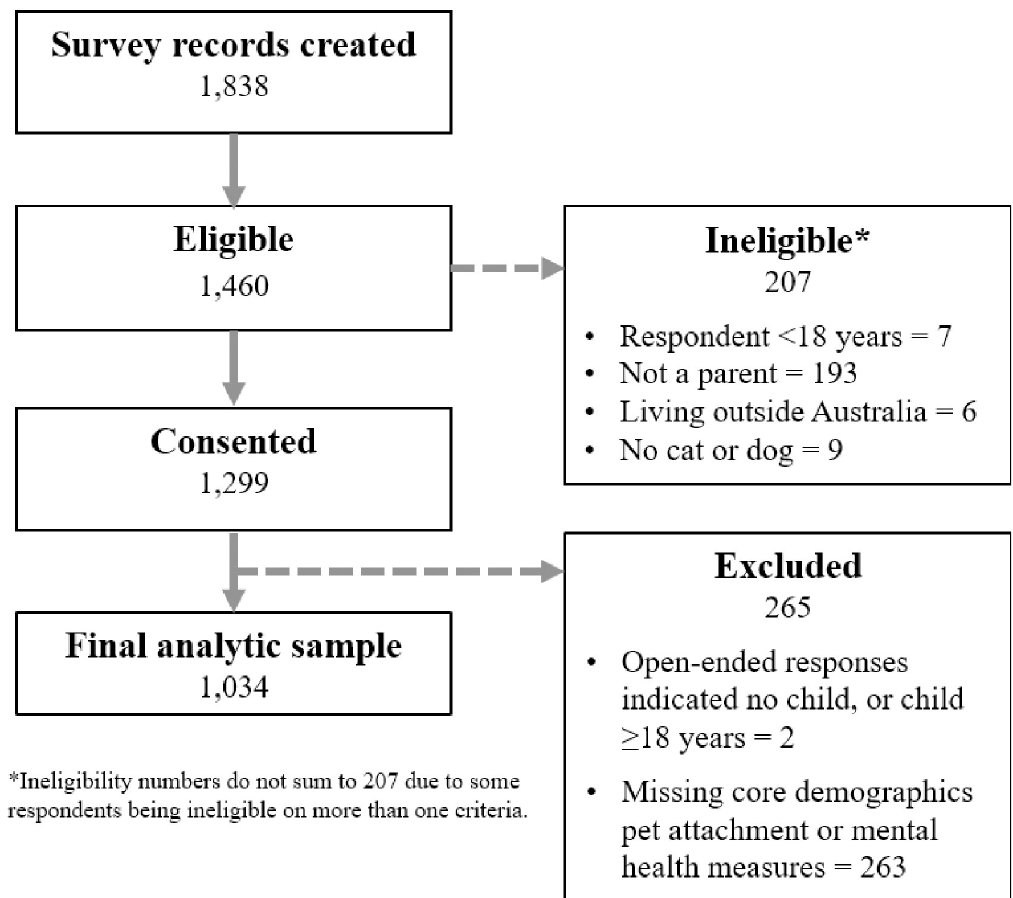
Fig 2. Participant flow from activation of survey link to survey